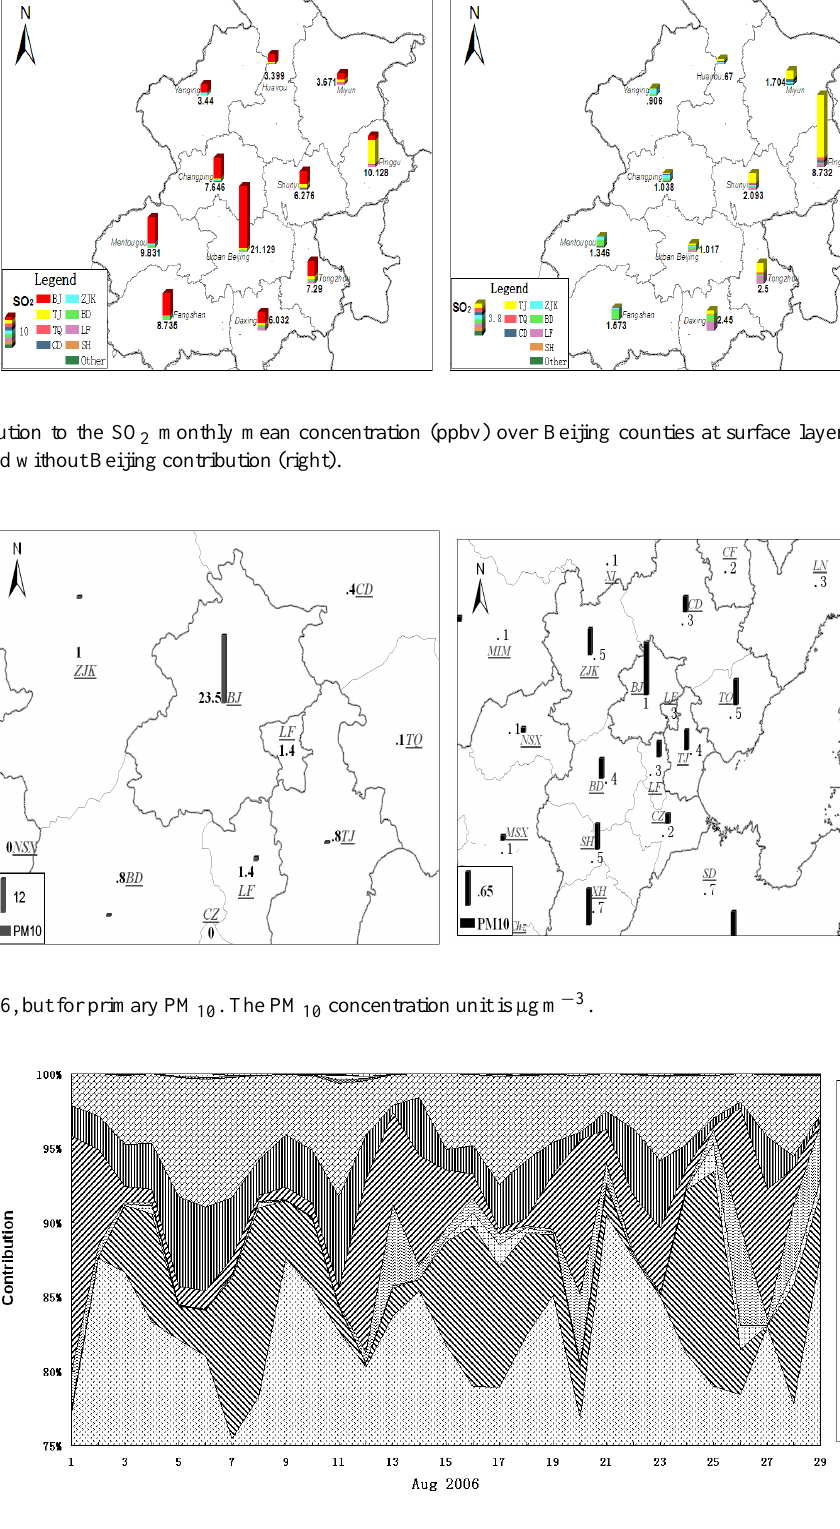
10 concentration in Beijing at the